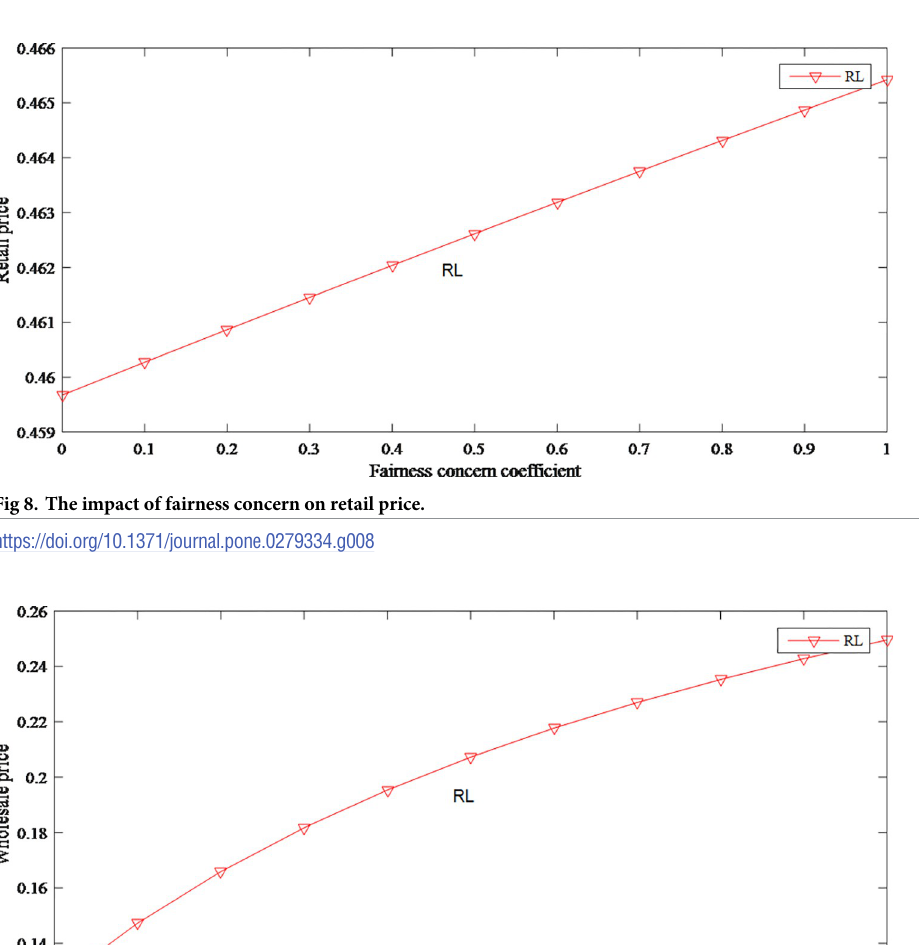
Fig 7. The impact of anticipated regret on the overall profits.